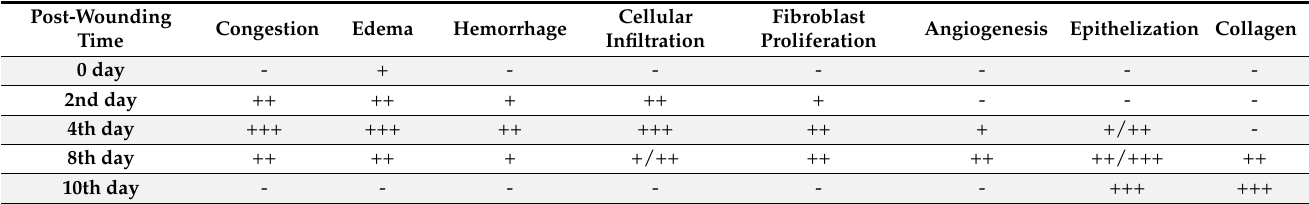
Table 1. Scoring of histopathological findings of injured cutaneous